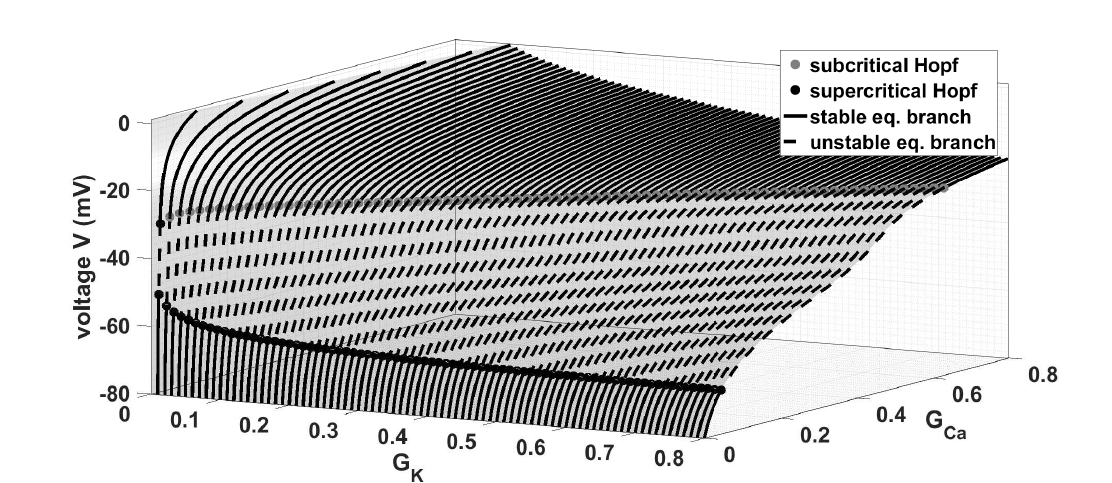
Figure 7. Bifurcation problem with G K and G Ca as bifurcation